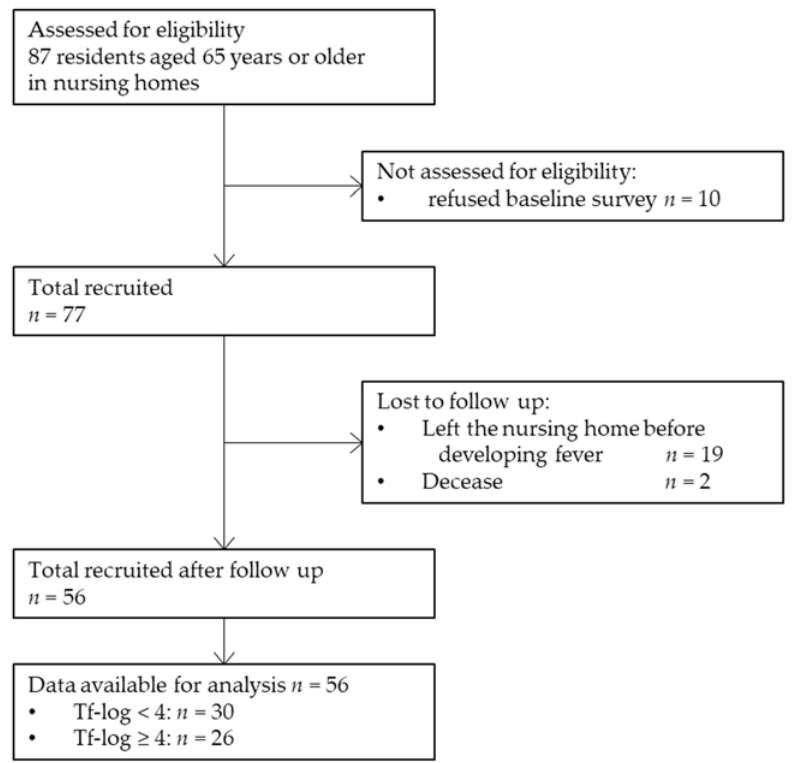
Figure 1. Flow diagram of the study participant selection. Tf-log: Logarithmic-conversed bacterial counts of Tannerella forsythia .